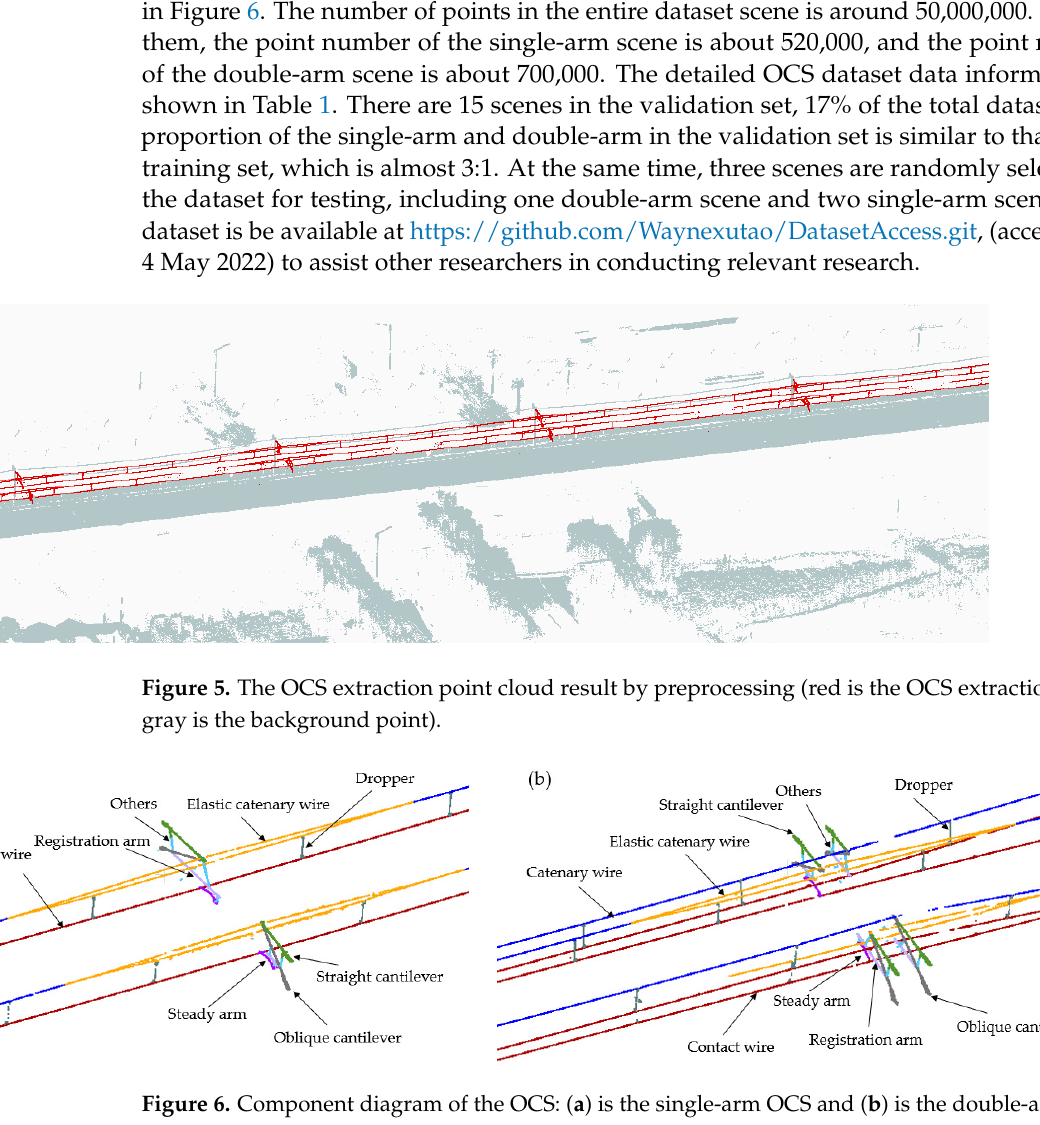
Table 1. Data distribution introduction in the OCS dataset.